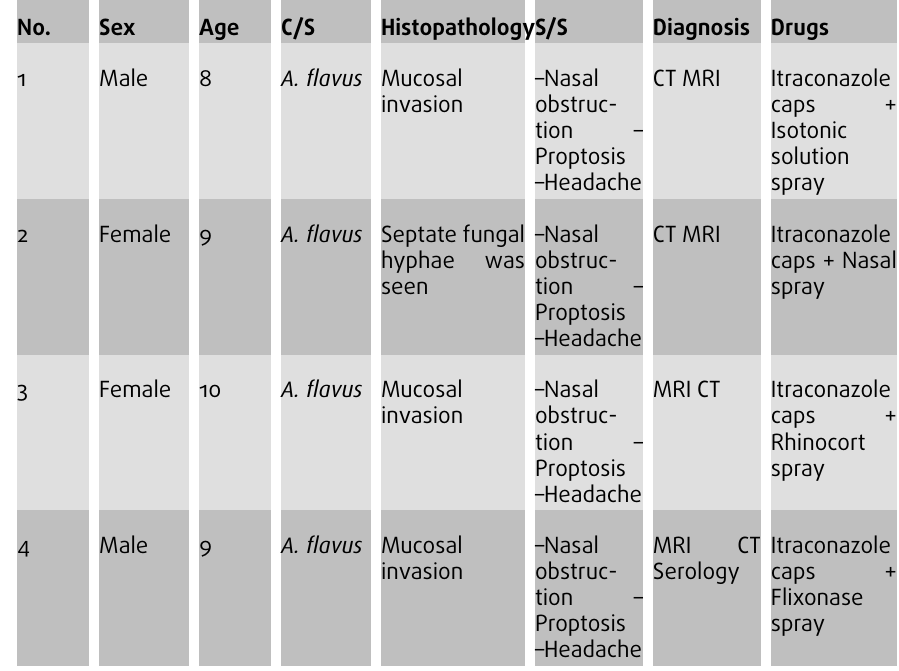
Table 1: The result of age, sex, culture/sensitivity (C/S), histopathology, symptoms /signs (S/S), images and drugs options.